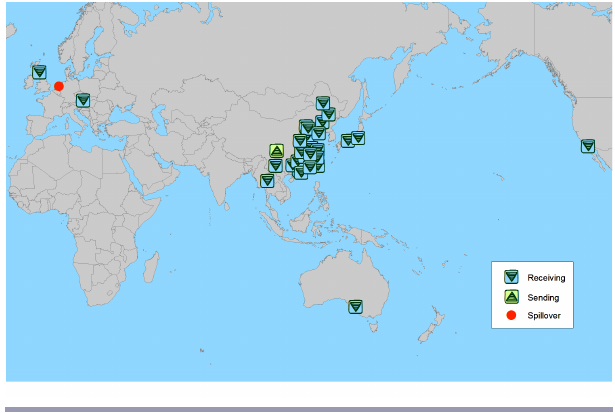
Fig. 4 . Sending, receiving, and spillover systems involved in panda loans. The Wolong Nature Reserve is the only sending system, while several worldwide zoos represent the receiving systems. Holland is marked as a spillover system because it is indirectly involved in the telecoupling by growing bamboo (Brown 2011) needed to feed pandas hosted at the Edinburgh Zoo. Each telecoupled system is represented as a centroid of the respective country.